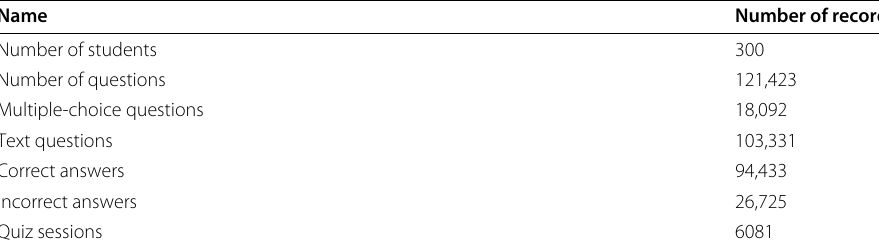
Table 1 Summary of collected